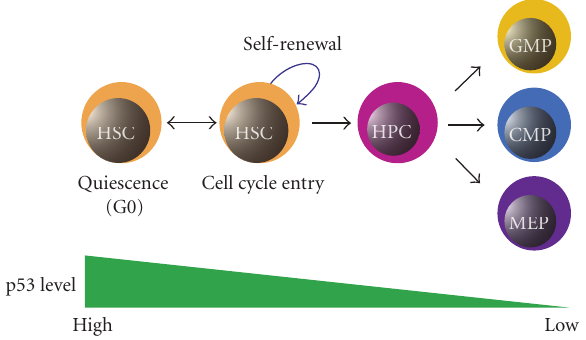
Figure 2: Regulation of quiescence and self-renewal in HSCs by p53. Maintenance of quiescence in HSCs needs proper expression of p53. Decrease in p53 expression promotes self-renewal and di ff erentiation of